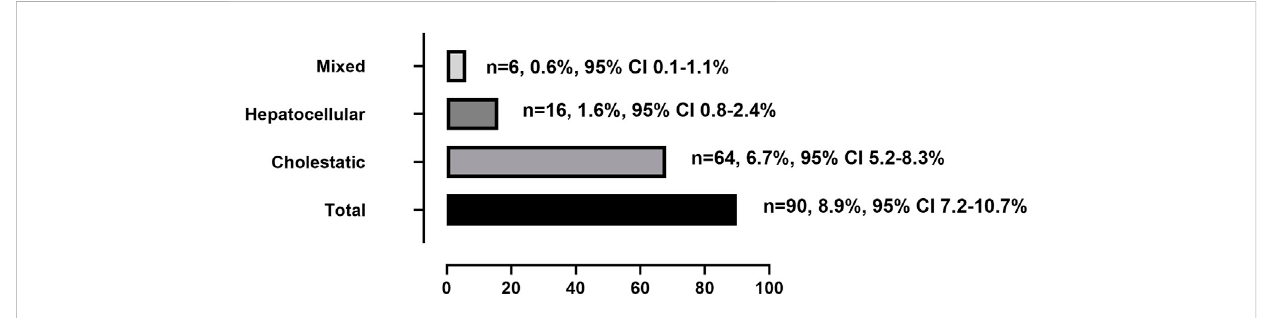
FIGURE 2 Incidence of total and different patterns of tacrolimus-induced liver